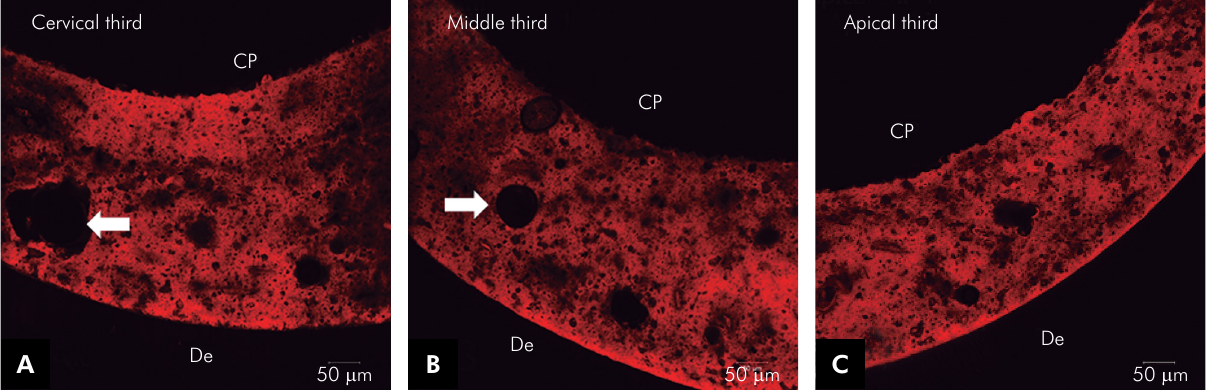
Figure 2. CLSM images (20x) of the interface between conventional fiberglass post and root dentin using RelyX U200 (2A, 2B, 2C). Red color: resin cement RelyX U200. The resin cement thickness decreases from the cervical third to the apical third. De: Dentin; CP: Conventional fiberglass post. Bubbles into the resin cements are identified by the